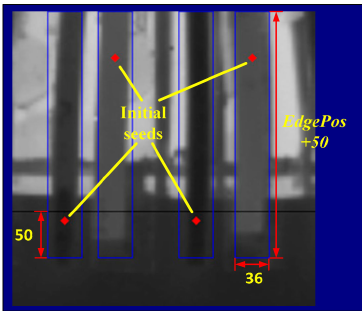
Figure 10. Illustration of the limiting growth range condition.